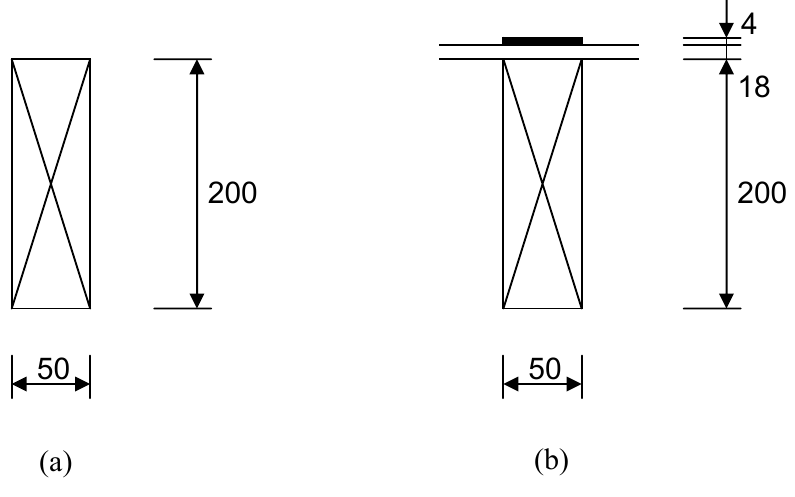
Figure 13. Layering-up of the FRP topping using two plates of 2 mm-thick CFRP and two plates of 3 mm-thick